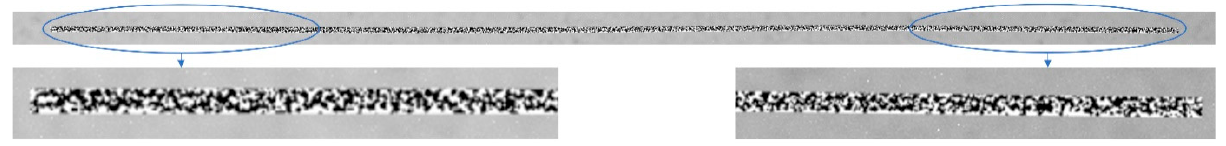
Figure 9. Exemplary rendered synthetic image presenting the side surface of the beam with